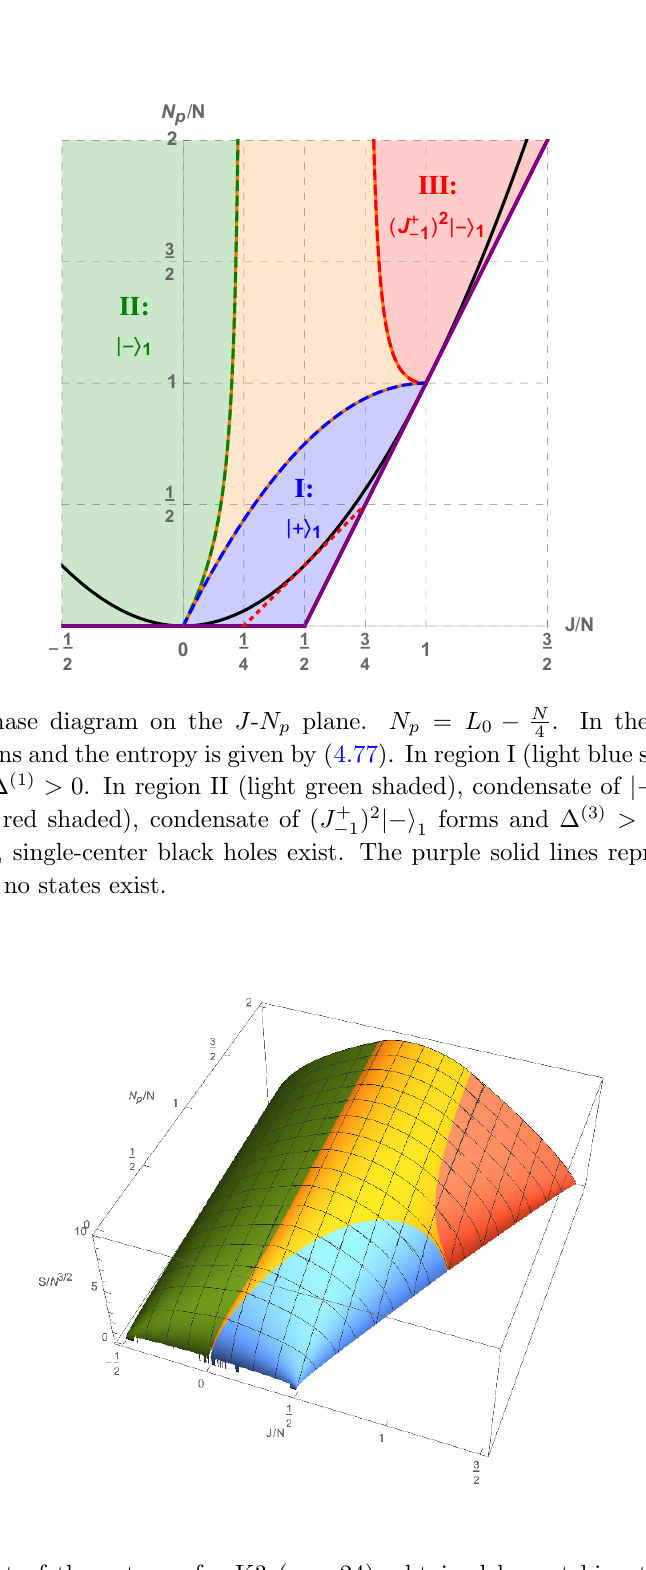
Figure 7 . The plot of the entropy for K3 ( c = 24), obtained by patching together the formu- lae (4.77), (4.81), (4.84), and (4.87) in di(cid:11)erent regions. See (cid:12)gure 6 for which color corresponds to which region. The case with T 4 is identical, except for the overall factor.